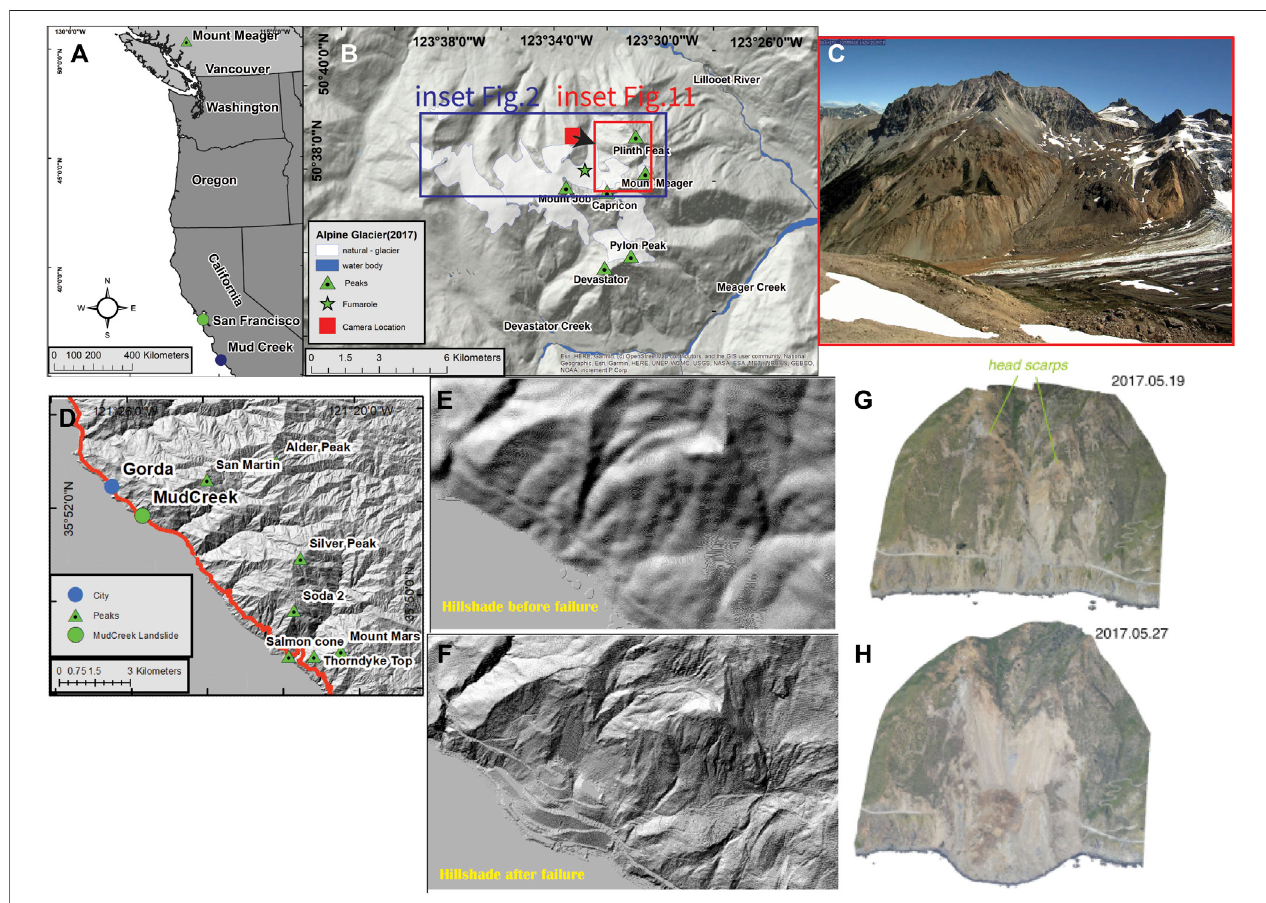
FIGURE 1 | Location of the study areas. (A) Regional basemap showing the locations of Mount Meager and Mud Creek relative to western North America. (B) Hillshademapshowingthelocationofimportantpeaks,fumaroles,andinstalledcamerastationintheMMVC;theredinsetrepresentstheapproximateareacapturedby the installed camera; the red square with black arrow indicates location and orientation of the camera view; the blue inset shows the area of Figure 2 . (C) Example of optical image on 10 August 2021, captured at 11 a.m. by the camera station. (D) Hillshade map show location of Mud Creek landslide and the surrounding mountain peaks. (E) Hillshade map showing the topography of the Mud Creek area before the failure. (F) Hillshade map showing the topography of the Mud Creek area after thefailure. (G) ObliqueaerialviewofMudCreek1 daybeforethefailurederivedfromaphotogrammetrymodel(after Warrick,etal.,2019). (H) Obliqueaerialviewof Mud Creek 7 days after the failure derived from a photogrammetry model (after Warrick, et al., 2019).